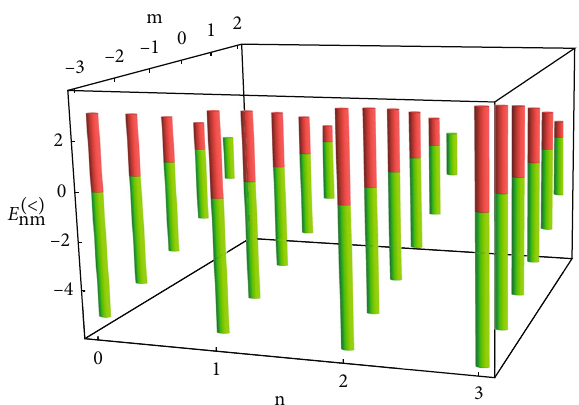
Figure 7: Sketch of the energy (Equation (71)) as a function of n and m for a = 0 : 5 , α = 0 : 5 , B = 1 , and ϕ = 1 .